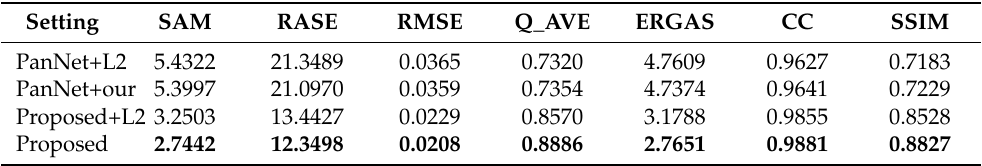
Table 7. Quantitative evaluation results of different loss functions. The best performance is shown in bold.